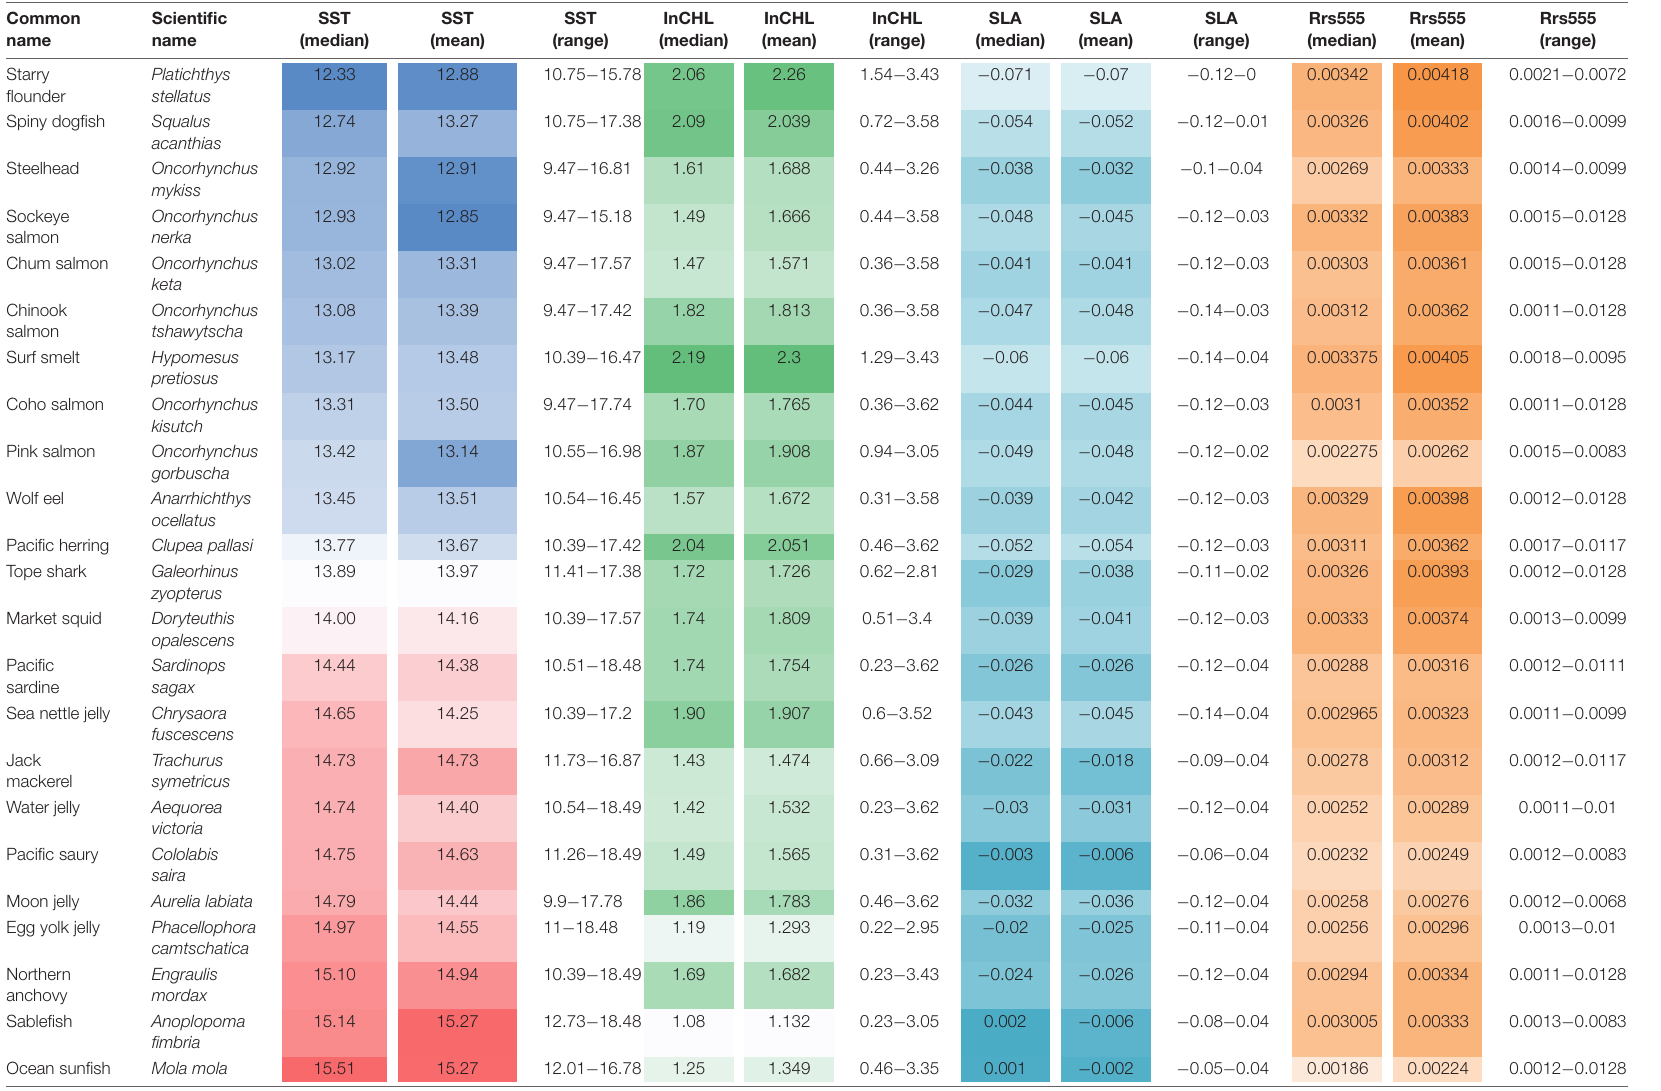
TABLE 1 | Summarized remotely sensed collocated data with positive presence for each species present in more than 3% of the total hauls conducted between 2003 and 2012 during the spring-summer